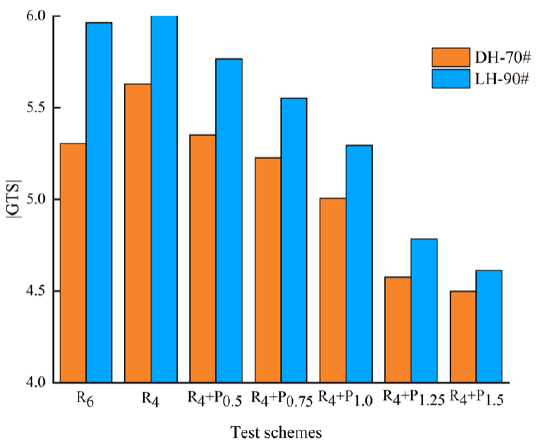
Figure 18. Effect of different PPA–SBR compound ratio on temperature sensitivity of asphalt.